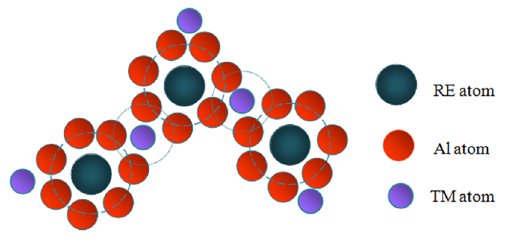
Figure 6. A skeleton of cluster packing in Al-based MGs.